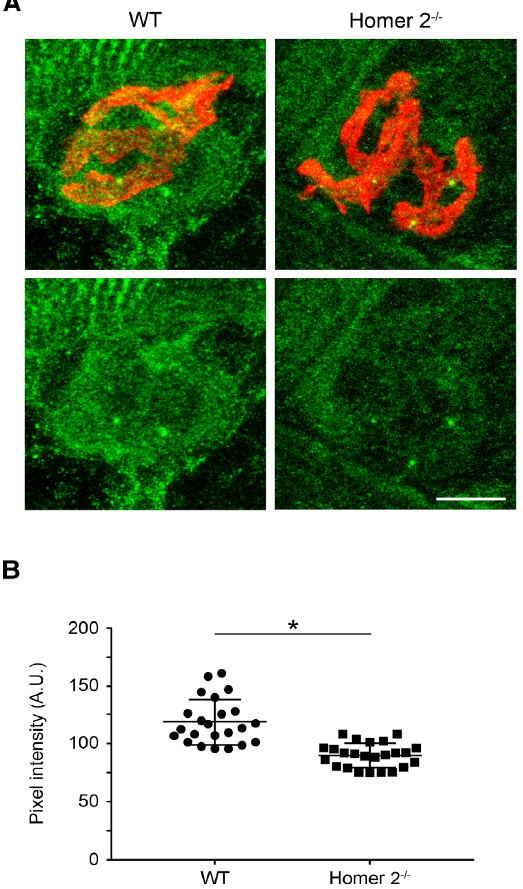
Figure 3. Homer immunoreactivity at the NMJ of SOL cryosections from WT and Homer 2 ‐ / ‐ mice. ( A ) SOL cryosections were stained for Homer using a pan ‐ Homer antibody (green) and for nAChRs ( A ) SOL cryosections were stained for Homer using a pan-Homer antibody (green) and for nAChRs using using Alexa ‐ 555 ‐α‐ BuTX (red) as described in the Materials and Methods section. Confocal micros ‐ Alexa-555- α -BuTX (red) as described in the Materials and Methods section. Confocal microscopy revealed copy revealed a reduced immunoreactivity for Homer in the NMJ subsynaptic region in Homer 2 ‐ / ‐ compared to WT mice (lower panels). Scale bar, 10 μ m. ( B ) Data are shown as pixel intensity at the a reduced immunoreactivity for Homer in the NMJ subsynaptic region in Homer 2 -/- compared to WT NMJ junction from either WT and Homer 2 ‐ / ‐ mice. Data were obtained from 3 animals per each mice (lower panels). Scale bar, 10 µ m. ( B ) Data are shown as pixel intensity at the NMJ junction from experimental group, and at least 23 endplates per group was analysed. Data are expressed as mean either WT and Homer 2 -/- mice. Data were obtained from 3 animals per each experimental group, and at ± SEM. Statistical differences were determined by unpaired t ‐ test. * p < 0.05 vs. the respective WT least 23 endplates per group was analysed. Data are expressed as mean ± SEM. Statistical differences control. were determined by unpaired t -test. * p < 0.05 vs. the respective WT